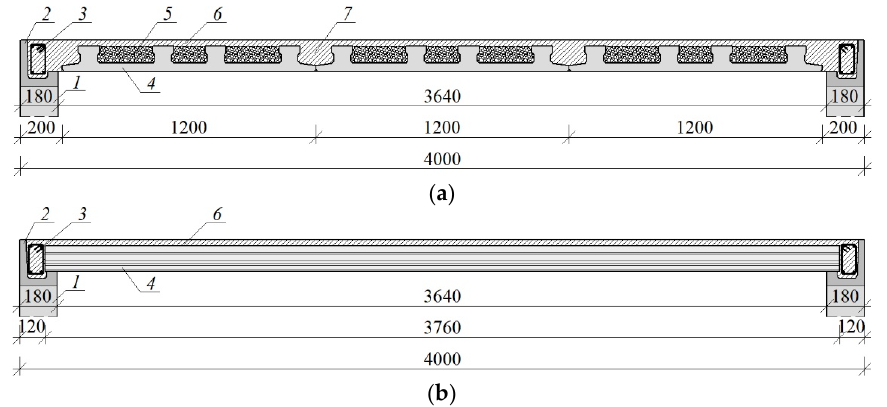
Figure 2. Construction stages; ( a ) formwork of the lower perimeter beam; ( b ) erection of masonry walls made of autoclaved aerated concrete; ( c ) slab top reinforcement; ( d ) concreting the slab. On the walls, precast L-shaped elements were laid, which were made of lightweight concrete. On the fittings, there was reinforcement consisting of Ø12 mm main rods and Ø 6 mm stirrups at a distance of 15 cm, similarly to the bottom beam. Instead of the traditional monolithic slab, a modern slab structure consisting of precast elements was made. Three prefabricated panels 1200 mm wide each with four prestressed ribs were used. In order to reduce the total weight of the slab, polystyrene was inserted between the ribs. The thickness of the precast slab element was 4 cm and 12 cm at the connection with the rib. Reinforcement hooks with a diameter of Ø10 mm with a spacing of 100 cm were built up on the perimeter, which constituted the upper reinforcement for a partial moment. The top surface reinforcement was placed at the very end in the form of Ø4 mm diameter nets with a mesh size of 15 cm—Figure 2c. After the reinforcement was made, the structure was monolithized with a 5 cm thick concrete overlay—Figure 2d. Figure 3 shows the details of the slab structure.